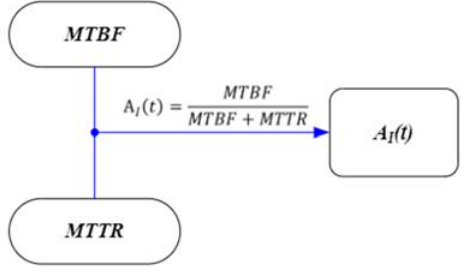
Figure 5. Correlation between reliability and maintenance.